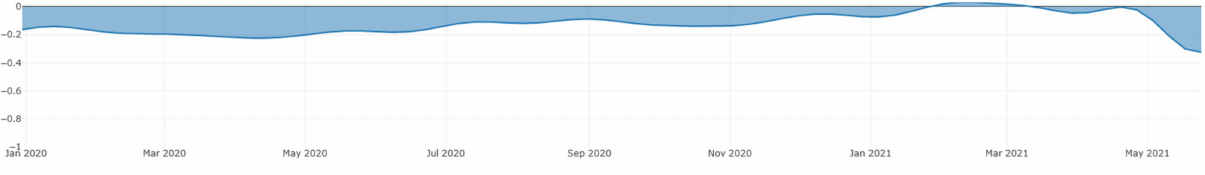
Figure A1. The dynamics of sentiment.